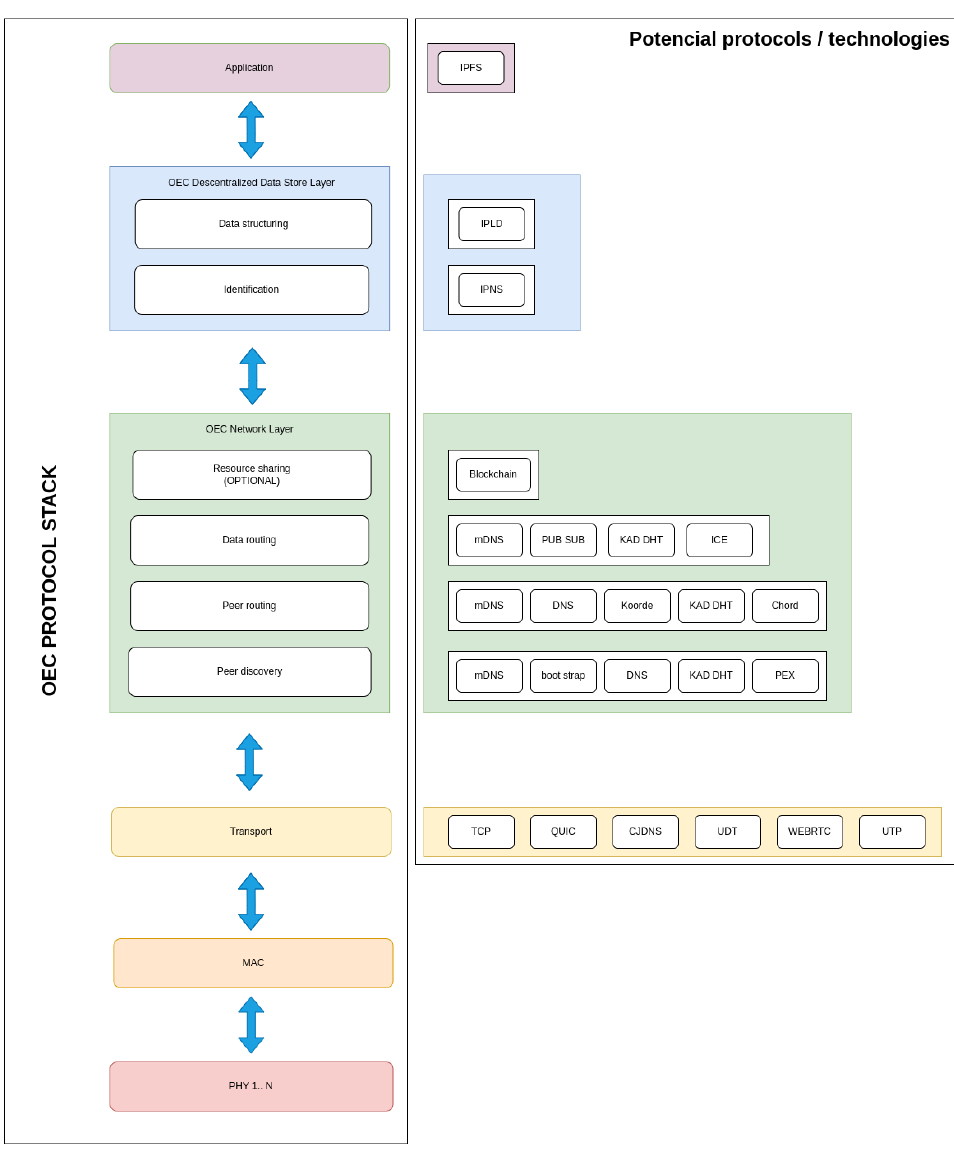
Figure 4. Proposed OEC protocol